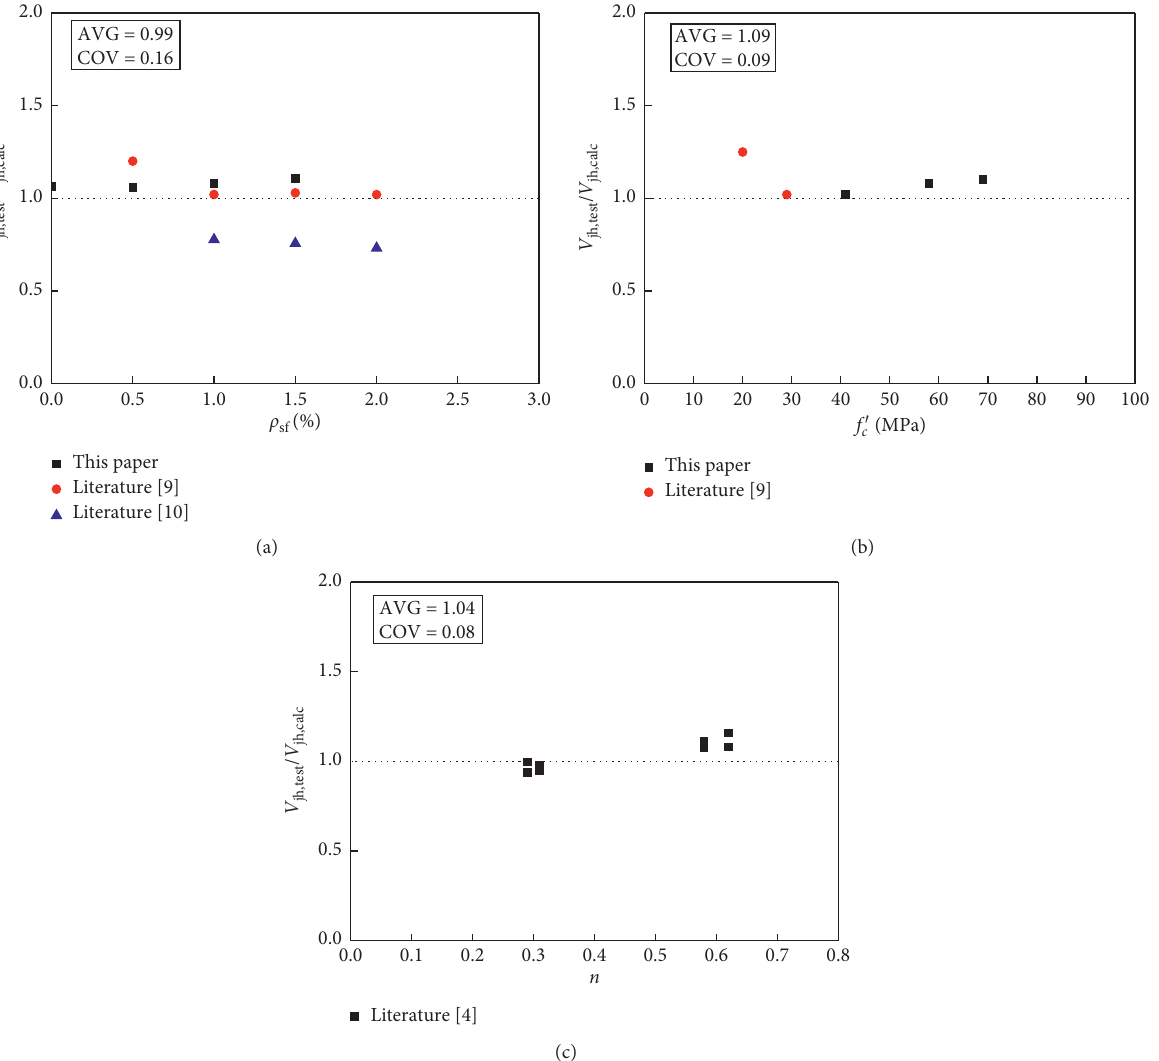
Figure 12: Effects on shear strength predictions. (a) Effect of steel fiber volume fraction on shear strength predictions. (b) Effect of concrete strength on shear strength predictions. (c) Effect of axial compression ratio on shear strength